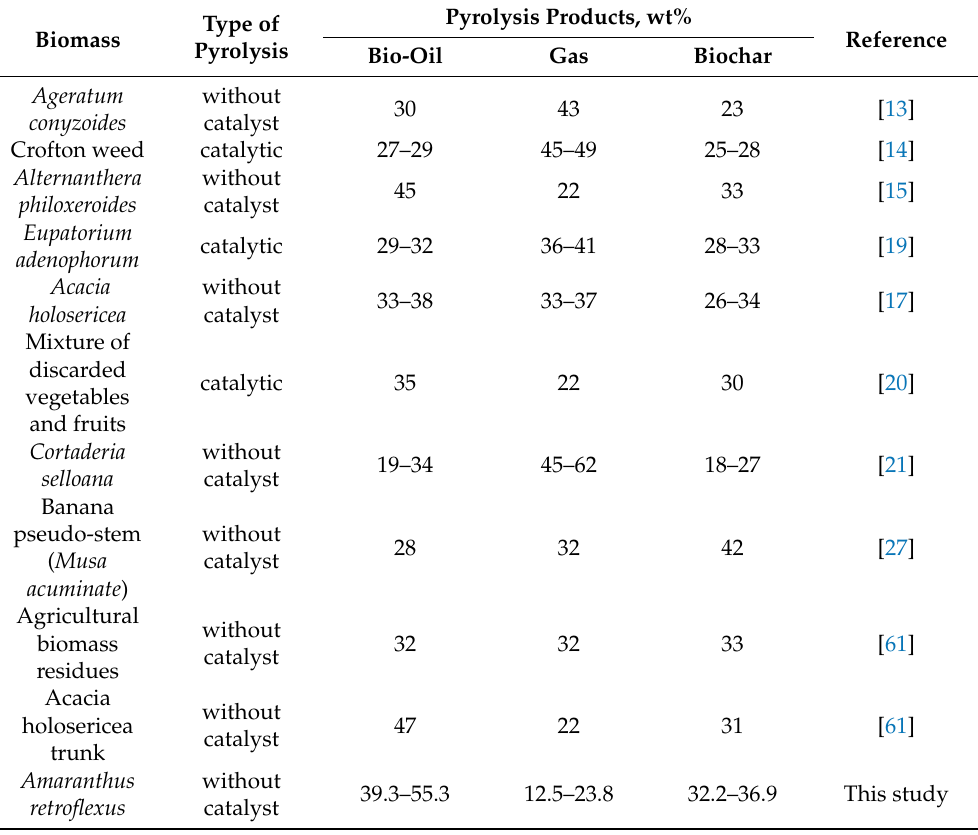
Table 5. Distribution of pyrolysis products obtained from various raw